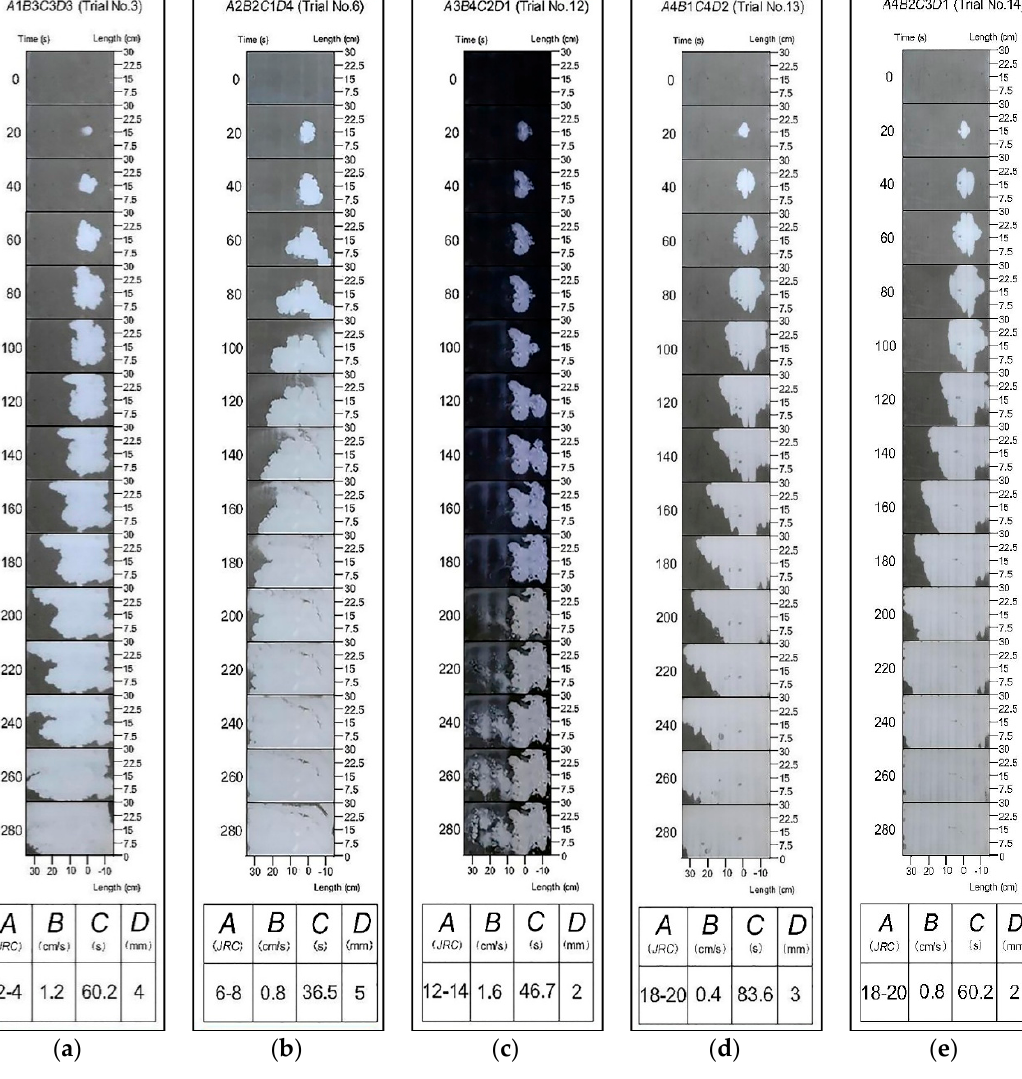
Figure 8. Images of grout diffusion along rough fracture. ( a ) Trial No.3. ( b ) Trial No.6. ( c ) Trial No.12. ( d ) Trial No.13. ( e ) Trial No.14.